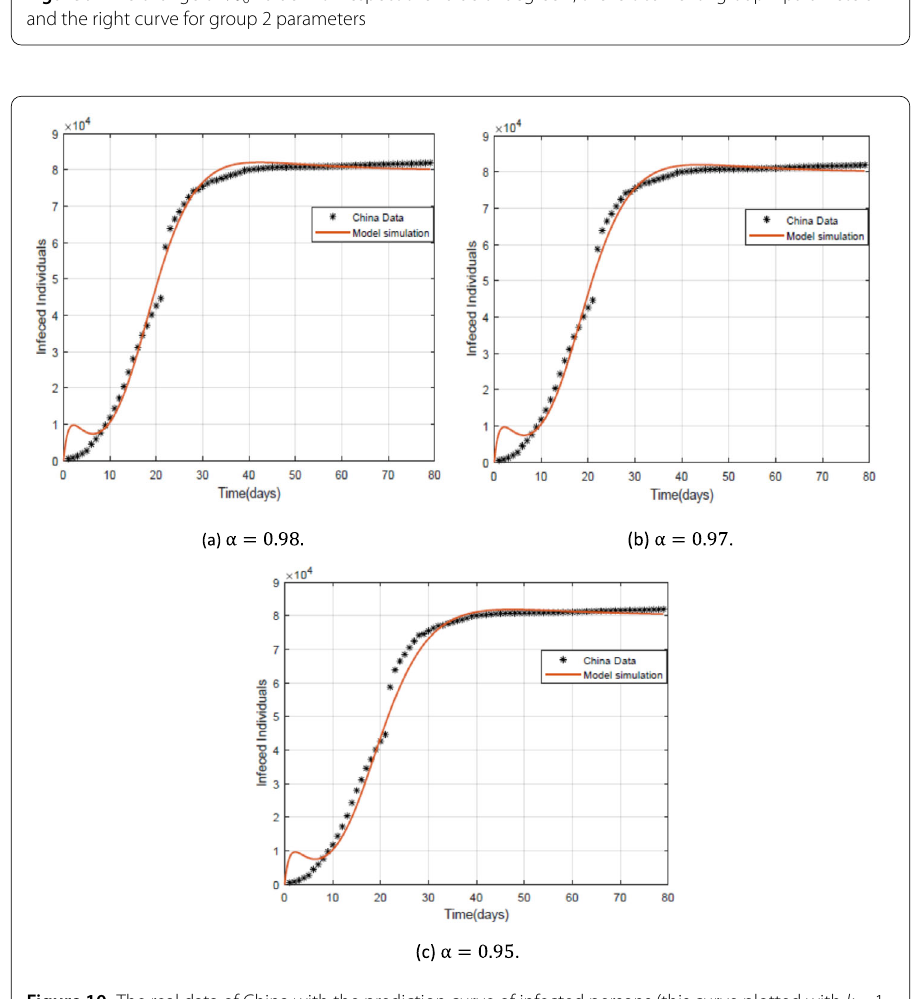
Figure 10 The real data of China with the prediction curve of infected persons (this curve plotted with k = 1,